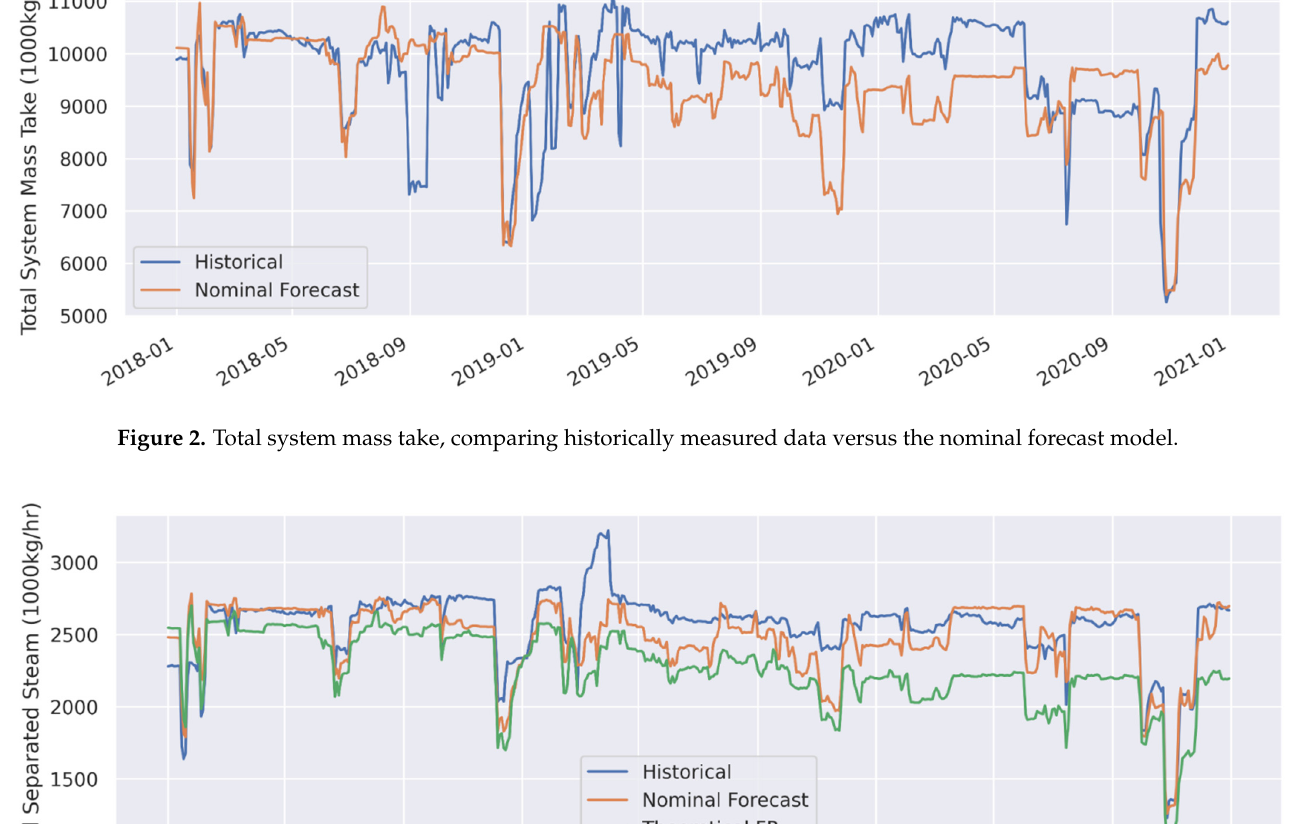
Energies 2021 , 14 , 6852